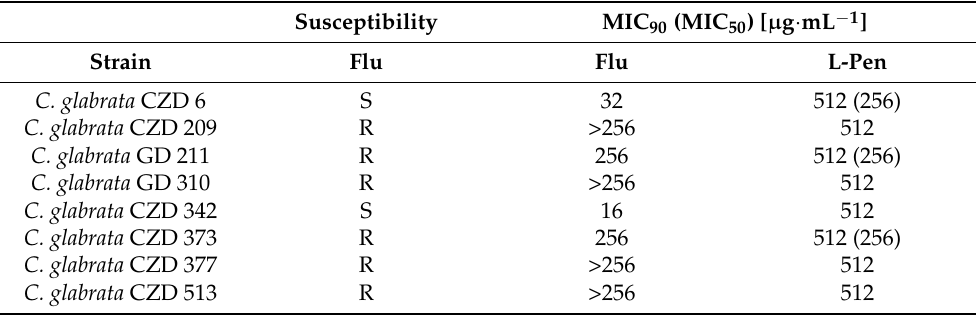
Table 3. Susceptibility of C. glabrata clinical isolates to L-Pen and Flu. MIC 90 (MIC 50 ), minimal inhibitory concentrations at which 90% (50%) of cells growth was inhibited. > Indicates no activity at the concentration mentioned; R, resistant to fluconazole; S, sensitive to fluconazole. The experiments were performed with at least three